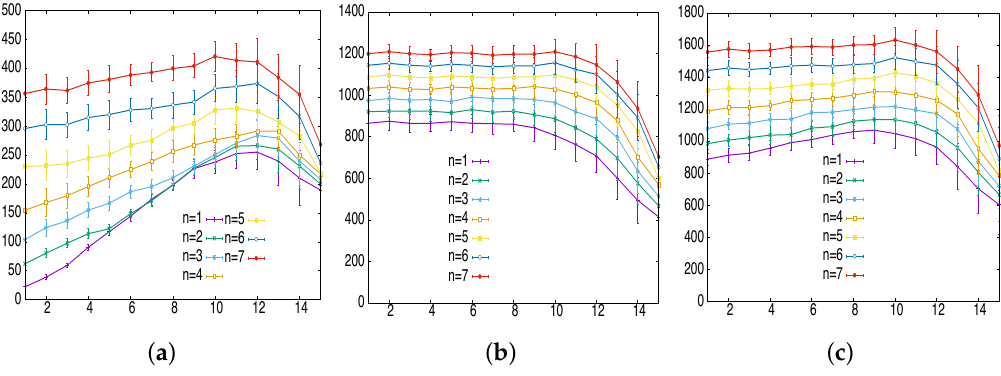
Figure 3. Simulation results in online markets with naive DA mechanism. ( a ) Buyers’ surplus; ( b ) Buyers’ resale profit; ( c ) Buyers’